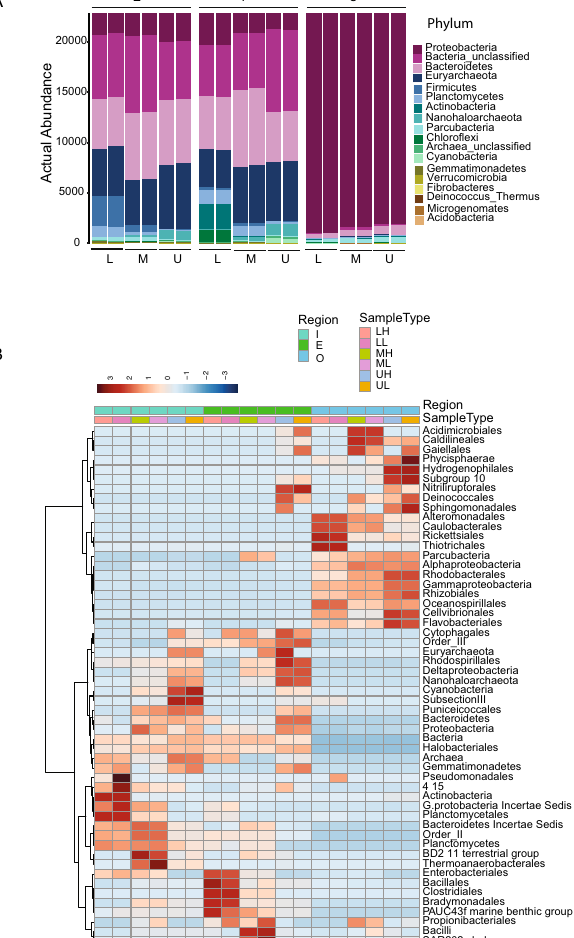
Figure 2. ( A ) Phylum level actual abundance of the inner and outer sabkha as well as different 3 cm layers (L: low; M: medium; U: upper). ( B ) Heatmap clustering of bacterial abundance as the order level, by type as well as by region inner and outer sabkha. Logarithmic value of OTUs abundance is represented by a color bar on top of the